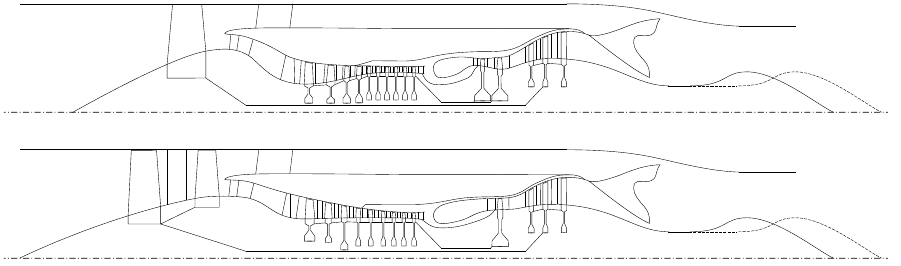
Figure 3. Schematics of possible engine configurations underlying the